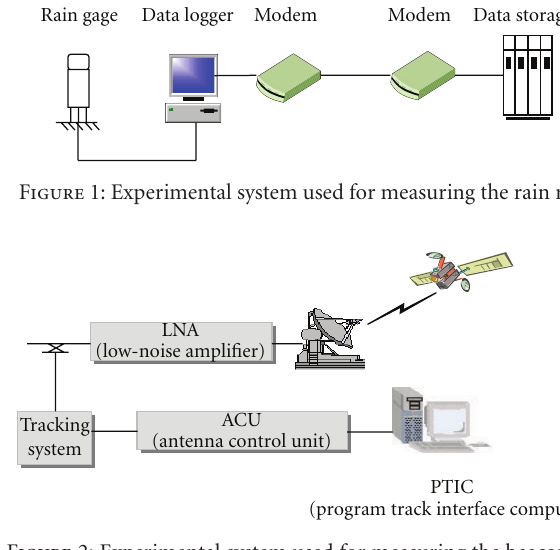
Figure 2: Experimental system used for measuring the beacon sig- nal